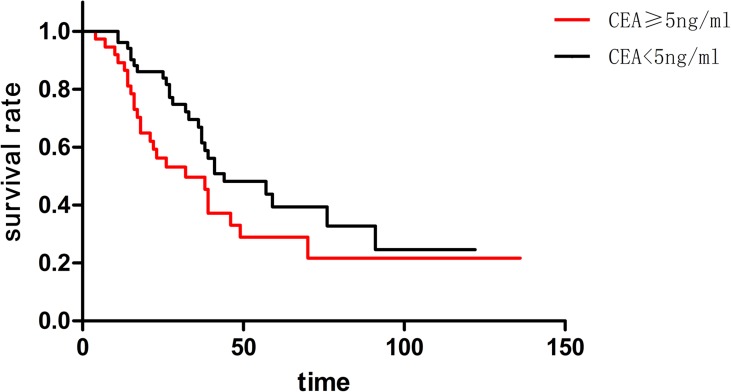
Though it seemed the CEA<5ng/ml group had a better behavior in survival than CEAastases.Mected patients. I"5 months, and 36 months or moreated.